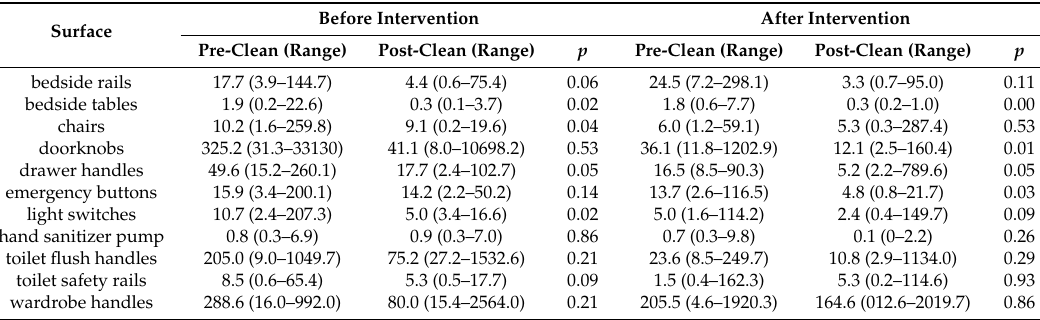
Table 1. Median RLU values (RLU/cm 2 ) before and after daily cleaning during the two study periods and p -values determined using the Wilcoxon signed-rank test ( N =